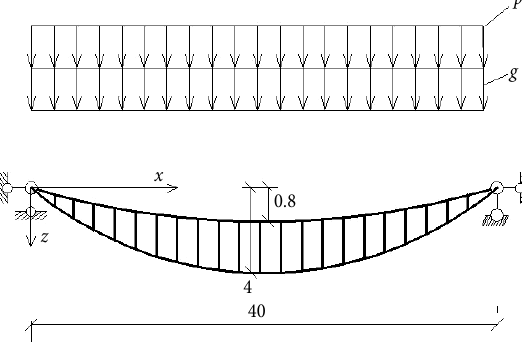
Fig. 2. Calculation diagram of the stress-ribbon structure with external tendons